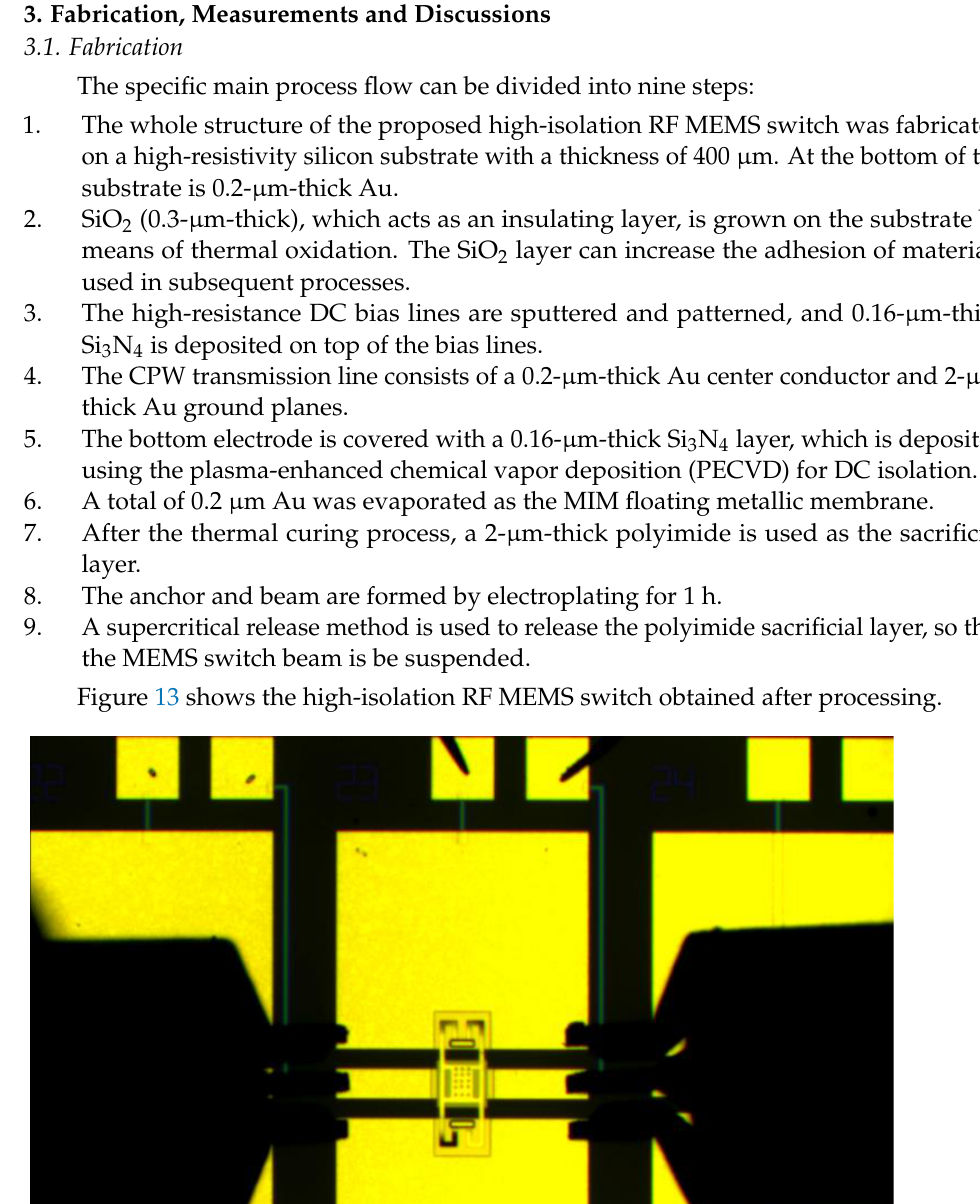
Figure 12. Simulated S parameters and current distribution diagrams: ( a , b ) up-state; ( c , d ) down- state.